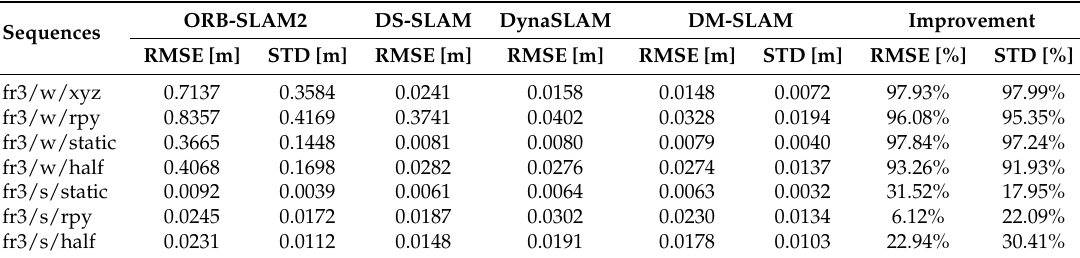
Table 1. Quantitative comparison results of the absolute trajectory error (ATE) [m] in meters for the